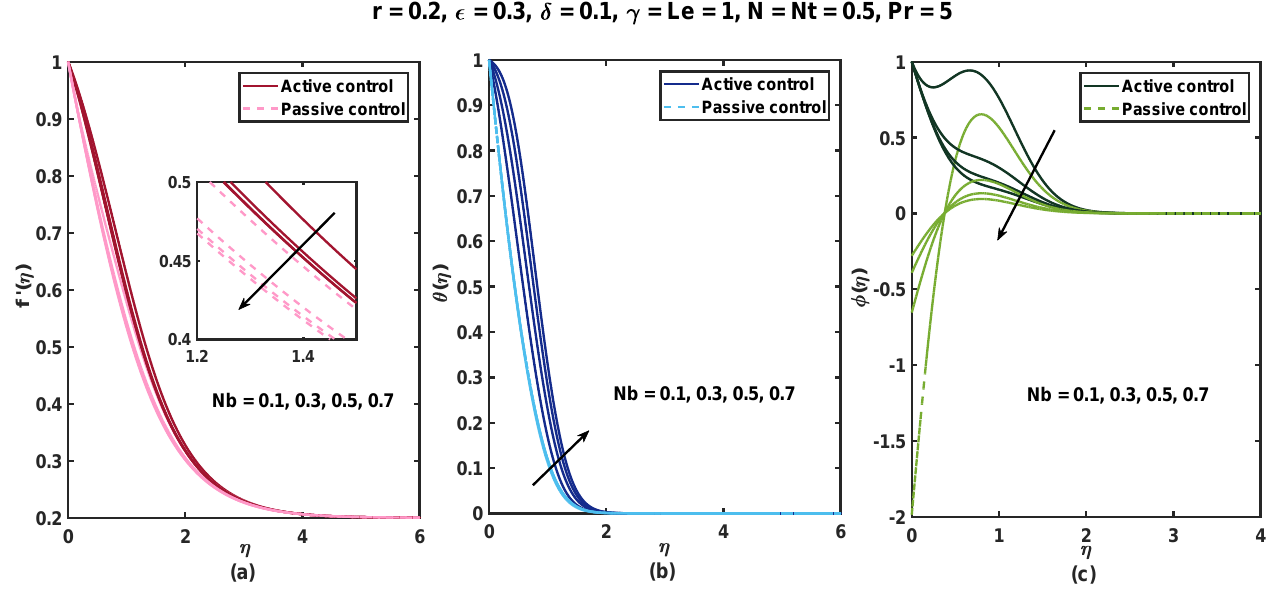
Figure 8. Impact of Brownian motionparameter Nb on( a )velocity, ( b )temperature, and( c )nanoparticlevolumefractionprofiles. Last but not least are the influences of Lewis numbers Le and Pr towards the fluid profiles as shown in Figures 9 and 10, respectively. Interesting results can be seen in the temperature profile between active and passive controls when Le is varied, where the trends turn out to be opposite to each other. Increasing Le will cause the temperature to rise under passive control but to decline under active control. Other than that, the fluid has a decreasing trend when Le and Pr increase.